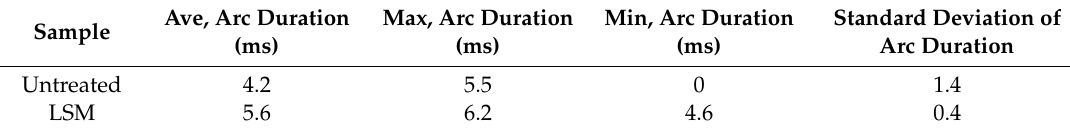
Figure 10. Arc duration measured by each switching off operation of the vacuum interrupters (VIs). Table 2. Arc duration features of different samples.